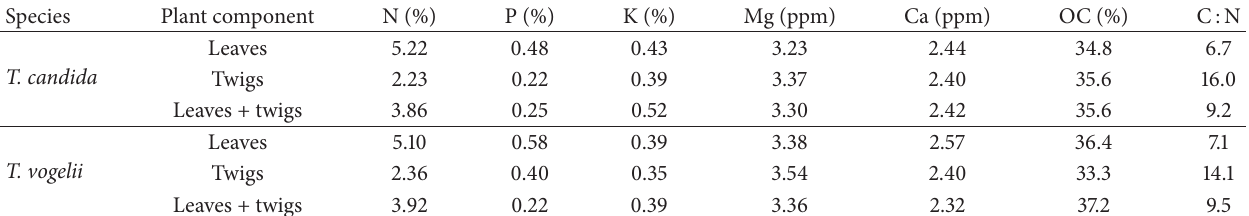
Table 3: Nutrient concentration of Tephrosia biomass used in the fallow experiment.